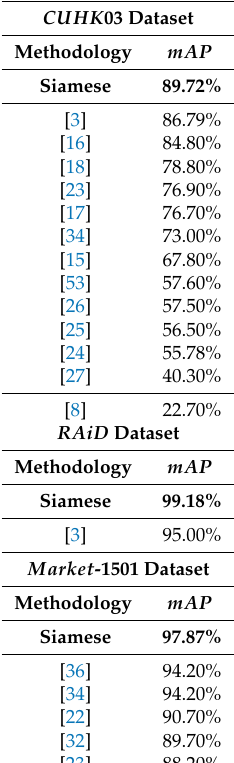
Table 7. mAP results of the Siamese network compared to state-of-the-art, per dataset, for the verification